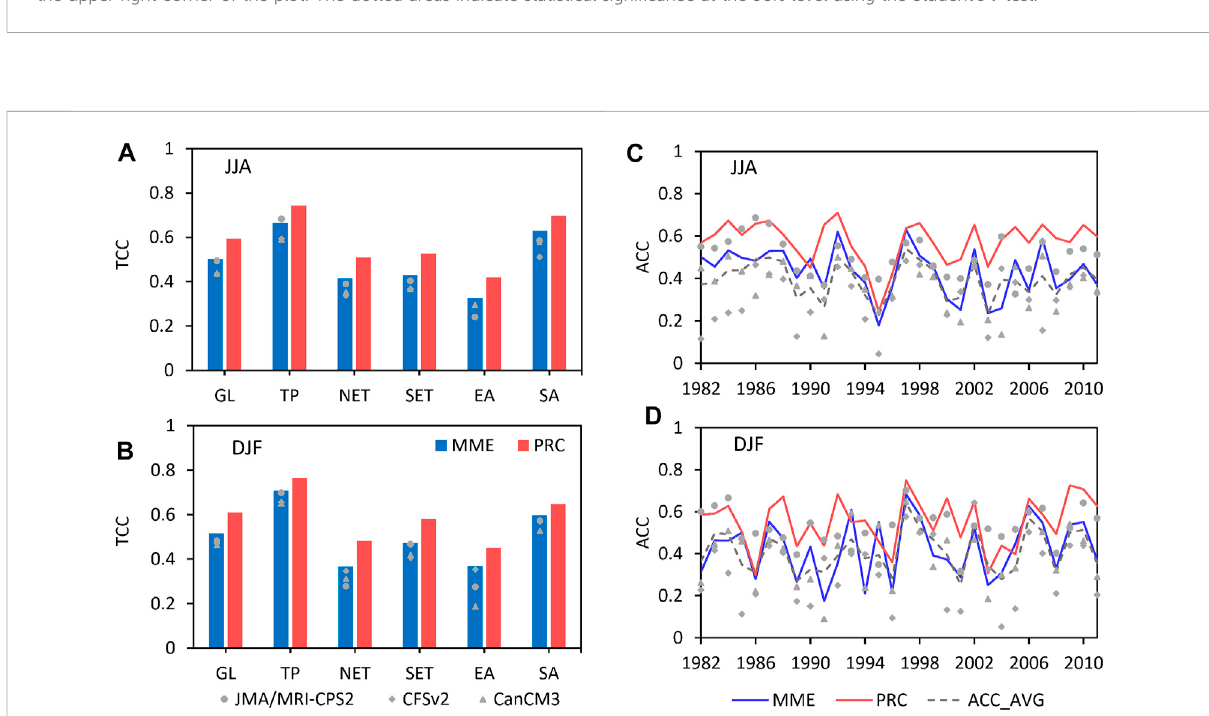
FIGURE 8 The area-averaged TCC (A,B) and time series of anomaly correlation coef fi cient (ACC) (C,D) for simple averaged multi-model ensemble (MME) and the ensemble with partial regression (PRC) of temperature in JJA (upper panel) and DJF (below panel) season for the period 1982 – 2011. The dashed line indicates the average ACC of the multi-model, and the gray marks present the ACC of the individual